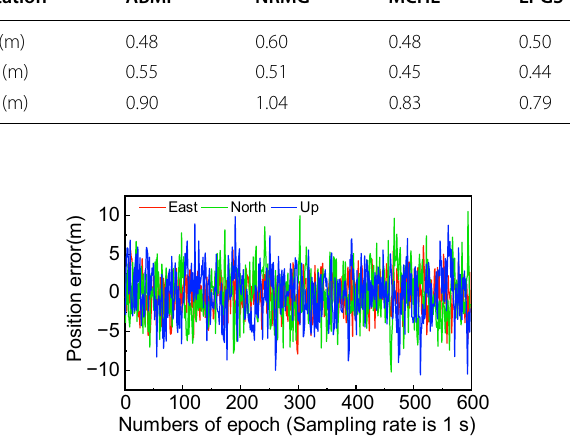
Table 5 RMSEs of kinematic Doppler positioning solutions at nine stations in scheme 2 Station